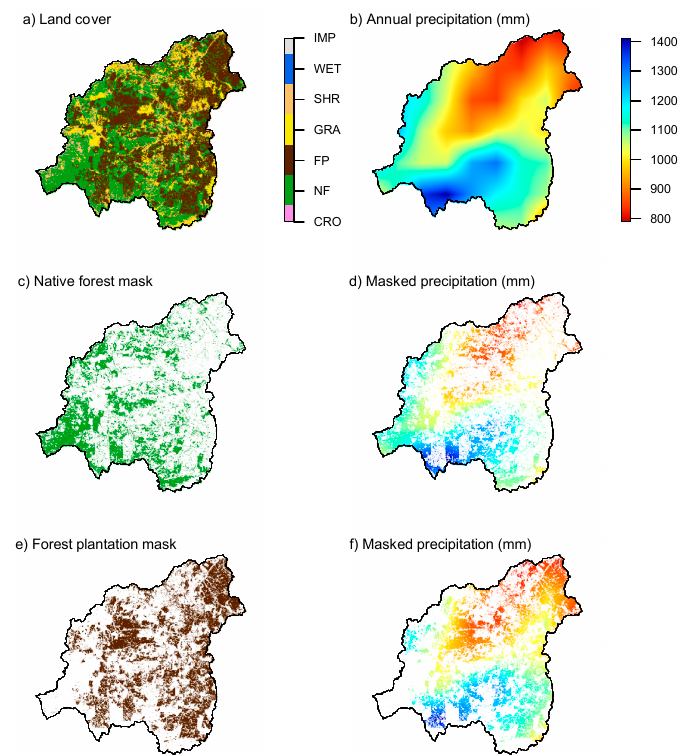
Figure 7. Example of data processing for catchment 8362001 (741 km 2 ). Panels ( a ) and ( b ) show the catchment land cover and annual precipitation (year 2013), respectively. The bottom panels correspond to the land cover and precipitation masks for NF ( c , d ) and FP ( e , f ).